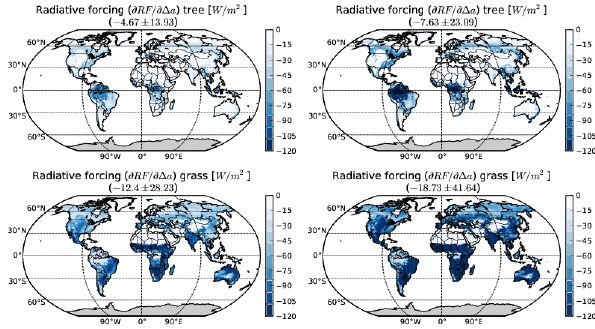
Fig. 6. Impact of a systematic albedo difference of 1α = 0 . 04 on Fig.6. Impactofasystematicalbedodifferenceof ∆ α =0 . 04 onradiativeforcingfortreecover(top)andgrassland(bottom),usingCERES solarradiationflux( R ↓ surf )anddifferentupwardatmosphericone-wayatmospherictransmissivity: Γ ↑ = const (left), Γ ↑ =Γ ↓ (right) radiative forcing for tree cover (top) and grassland (bottom), us- ↓ ) and different upward at- ing CERES solar radiation flux ( R surf mospheric one-way atmospheric transmissivity: 0 ↑ = const (left), 0 ↑ = 0 ↓